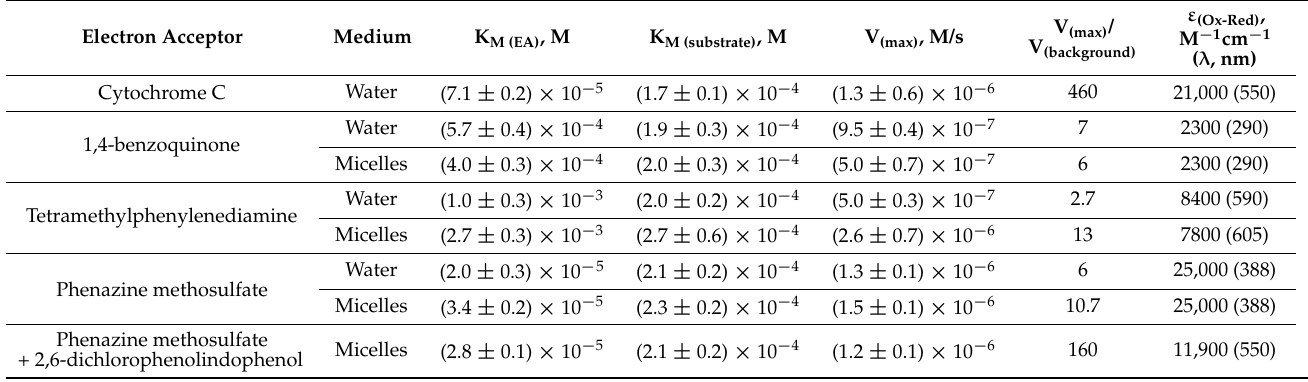
Table 2. Parameters of the studied EAs in aqueous and micellar media. The enzyme concentration was 6 × 10 − 9 M. In experiments to determine the K M for EA, the concentration of L -galactone-1,4-lactone (1 mM) was kept constant, while varying the EA concentration as follows: 2–150 µ M for cytochrome C, 0.1–4 mM for 1,4-benzoquinone (water and micelles), 0.1–8 mM for